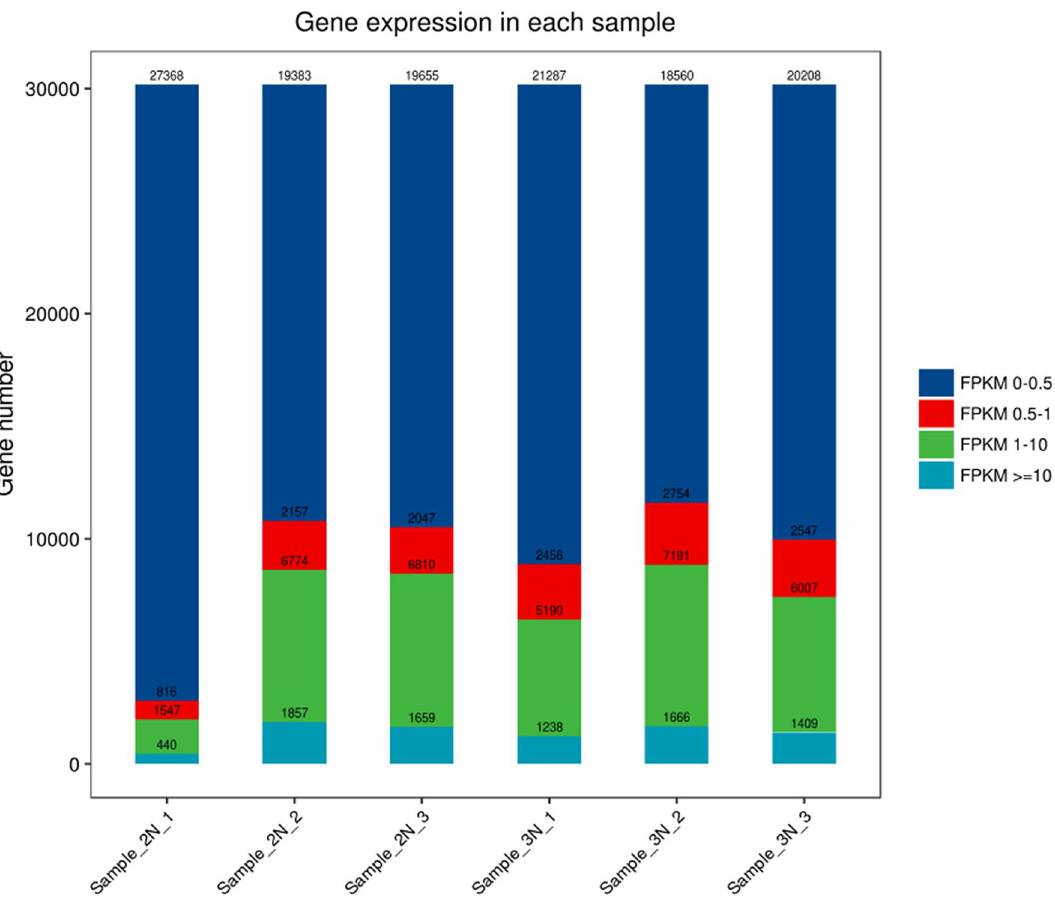
Figure 2. Distribution of FPKM expression. The horizontal axis represents the sample name, the vertical axis represents the number of protein-coding genes, and different colors represent different ranges of